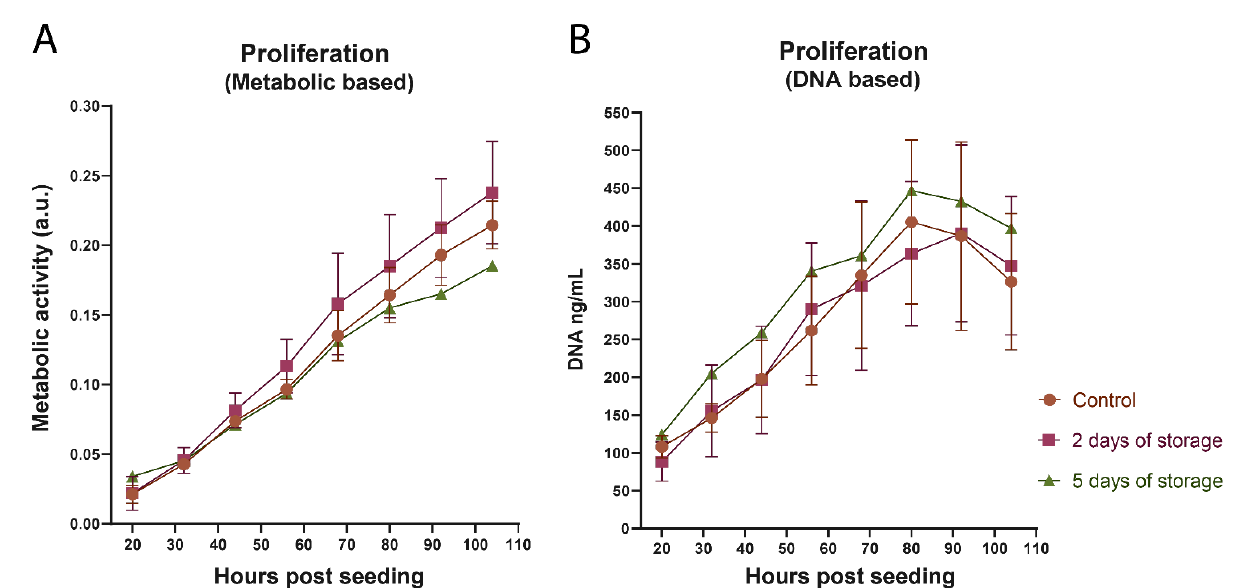
Figure 2. Proliferation of isolated cells measured by metabolic activity ( A ) and DNA concentrations ( B ). Satellite cells isolated on the day of tissue arrival (control) and after 2 and 5 days of storage were analyzed measuring metabolic activity (Figure 2A) and DNA concentration (Figure 2B). The data points represent the mean ± SEM based on three cows in triplicates ( n = 3) for control and 2 days of storage, while 5 days of storage is only based on one cow in triplicates ( n = 1). The Y-axis in Figure 2A is metabolic activity in arbitrary units (a.u.) based on 450 nm absorption. The Y-axis in Figure 2B is DNA concentration in ng/mL based on a known internal DNA standard.